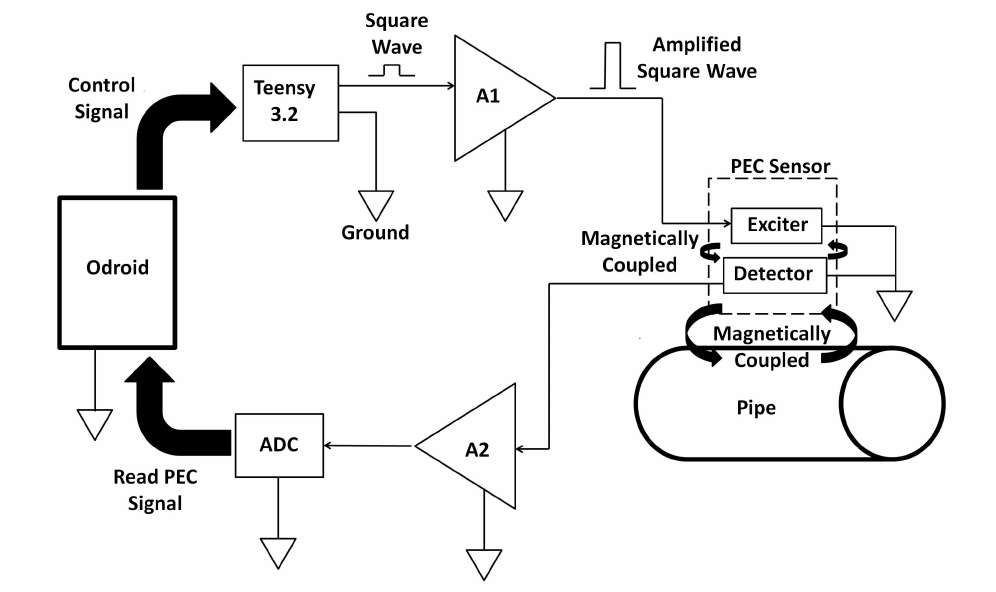
Figure 9. Block diagram of the PEC sensing setup.